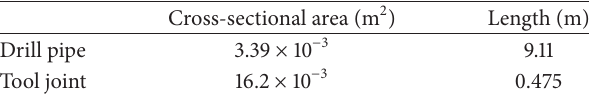
Table 1: Drillstring